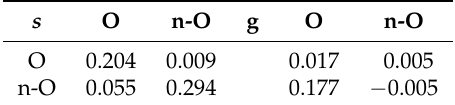
Table A1. Parameter calibration for spillover parameter s and g .